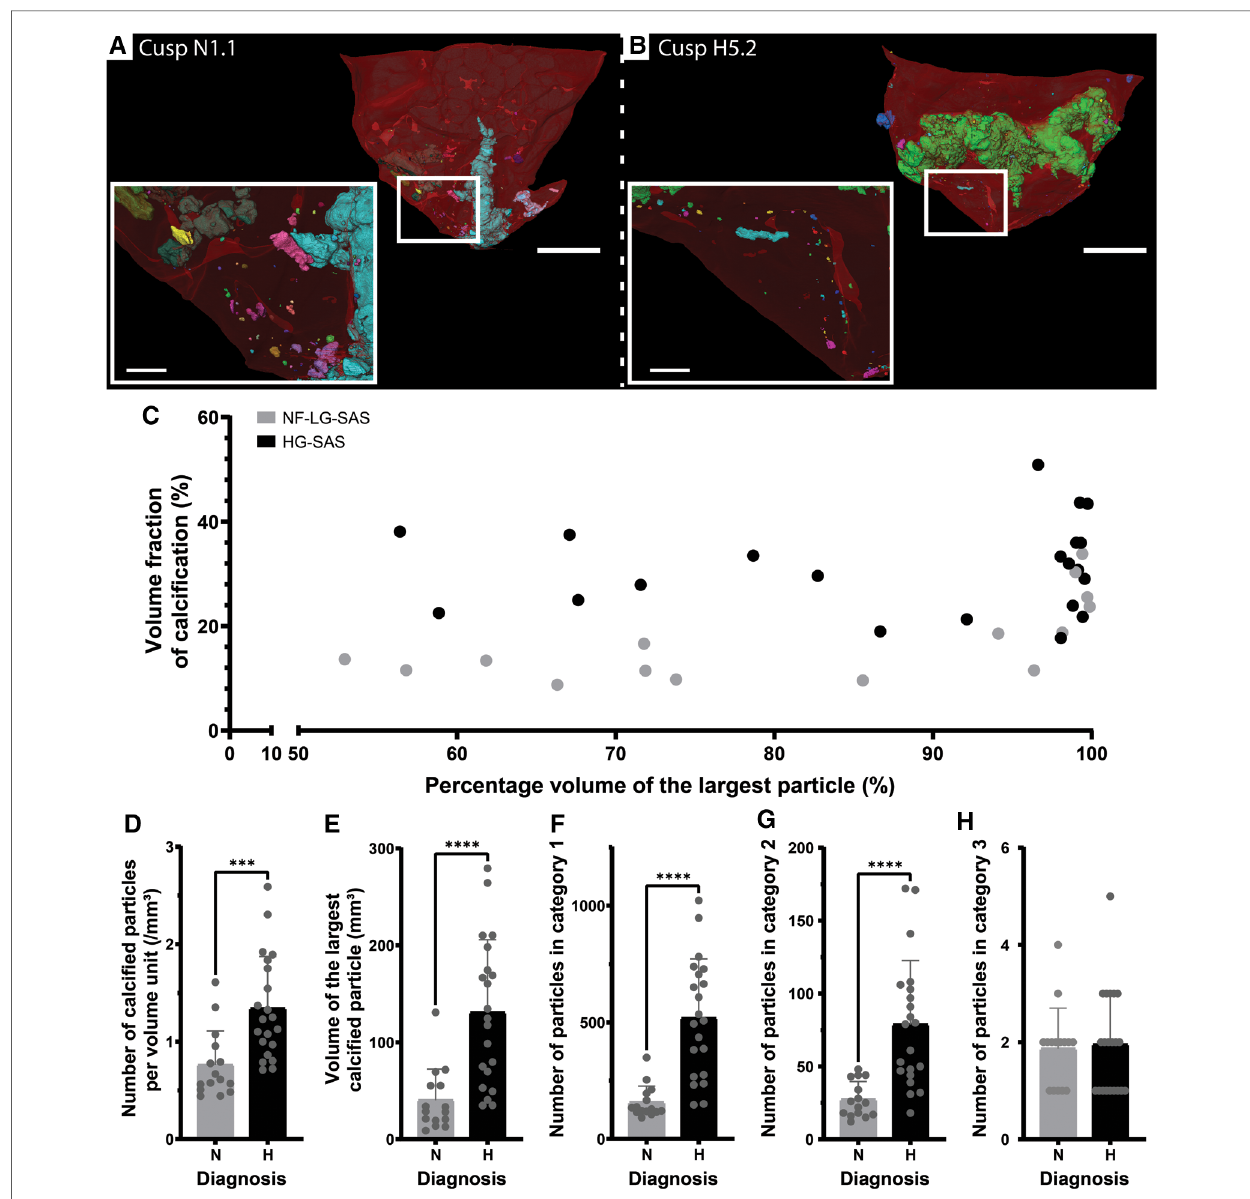
FIGURE 2 Quanti fi cation of the number and volume of calci fi ed particles. ( A,B ) 3D renderings of the cusp N1.1 ( A ) and cusp H5.2 ( B ). Clusters of voxels identi fi ed as calci fi cation and connected to each other are considered as one particle and displayed in the same color. Colors of particles are independent of any morphometrical quanti fi cation. Soft tissue is shown in red. A magni fi cation (white square) is shown in the inset. Scale bars=5 mm for the overview images and 1 mm for the inset. ( C ) Percentage volume of the largest particle in function of the volume fraction of calci fi cation present in the cusp for the NF-LG-SAS samples and the HG-SAS samples. ( D – H ) Bar graphs comparing the number of calci fi ed particles per volume unit ( D ), the volume of the largest particle ( E ), the number of particles in category 1 ( F ), category 2 ( G ) and category 3 ( H ), respectively for the NF-LG-SAS and HG-SAS groups. N, NF-LG-SAS; H, HG-SAS, ***: p -value<0.001, ****: p